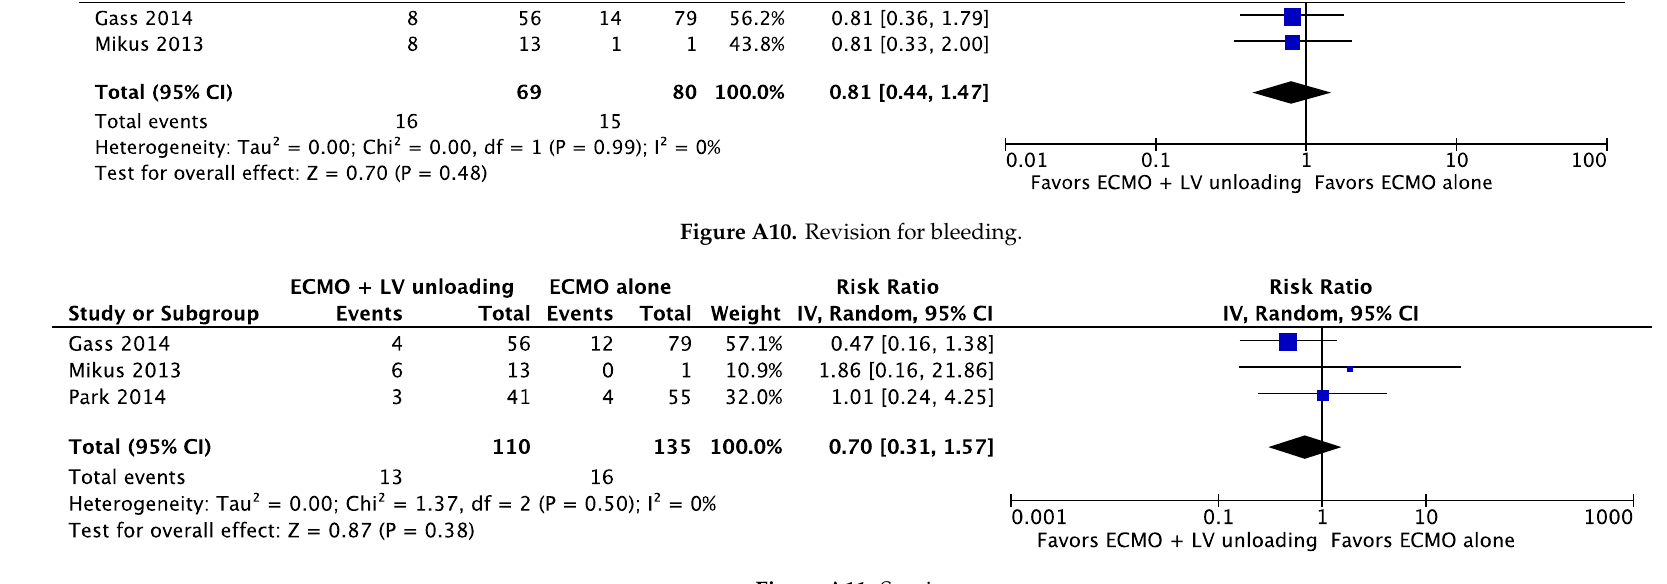
Figure A11. Figure A11. Sepsis. Figure A11. Sepsis.